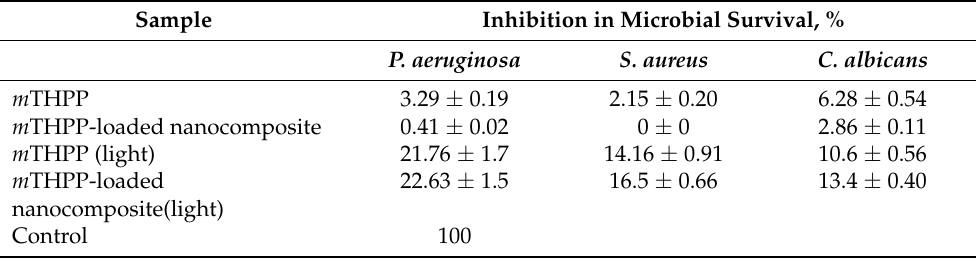
Table 2. Screening of the antimicrobial activity of m THPP and m THPP-loaded nanocomposite in the presence and in the absence of red laser light (635